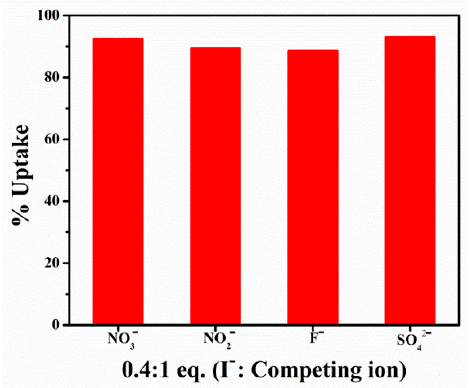
Figure 5. Relative uptake for I − anions in a binary mixture of competing anions.